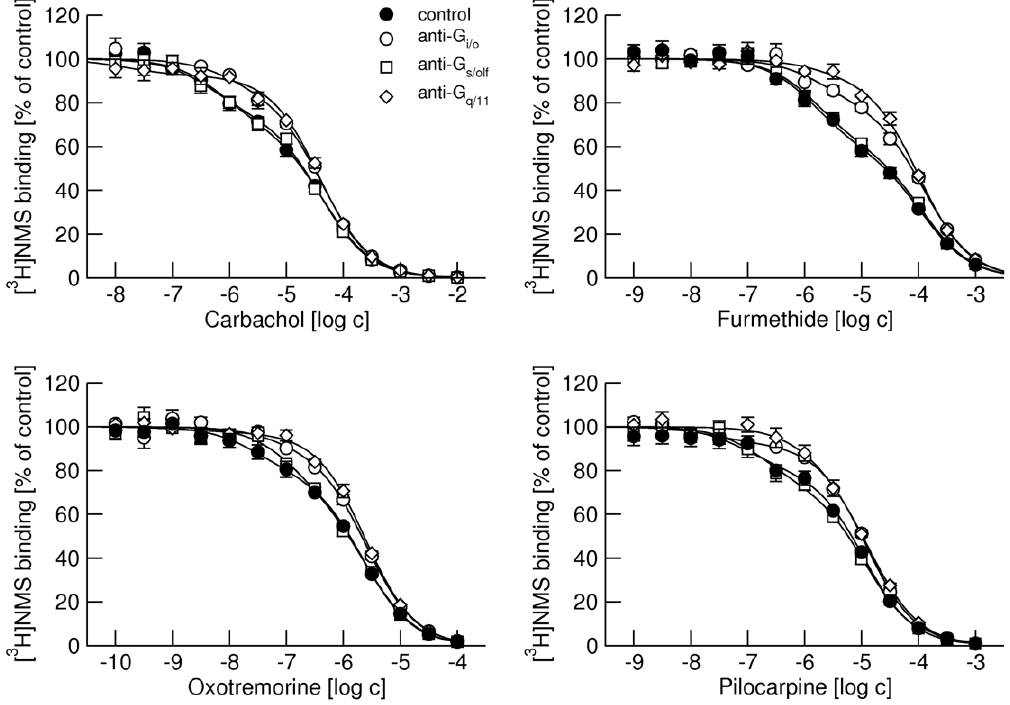
Figure 3. Effects of anti-G-protein antibodies on competition between different agonists and [ 3 H]NMS binding at M 1 receptors. Binding of 1 nM [ 3 H]NMS to membranes from CHO cells expressing M 1 receptors in the presence of increasing concentrations (abscissa, log M) of the agonists carbachol (upper left), furmethide (upper right), oxotremorine (lower left) and pilocarpine (lower right) is expressed as per cent of control binding in the absence of agonist. Filled circles, control binding in the absence of antibodies. Open symbols, binding in the presence of anti-G i/o (circles), anti-G s/olf (squares) and anti-G q/11 (diamonds) antibodies. Data are means 6 S.E.M of values from 3 experiments performed in quadruplicates. Curves were fitted using equation 3 and results of fits are shown in Table 3.